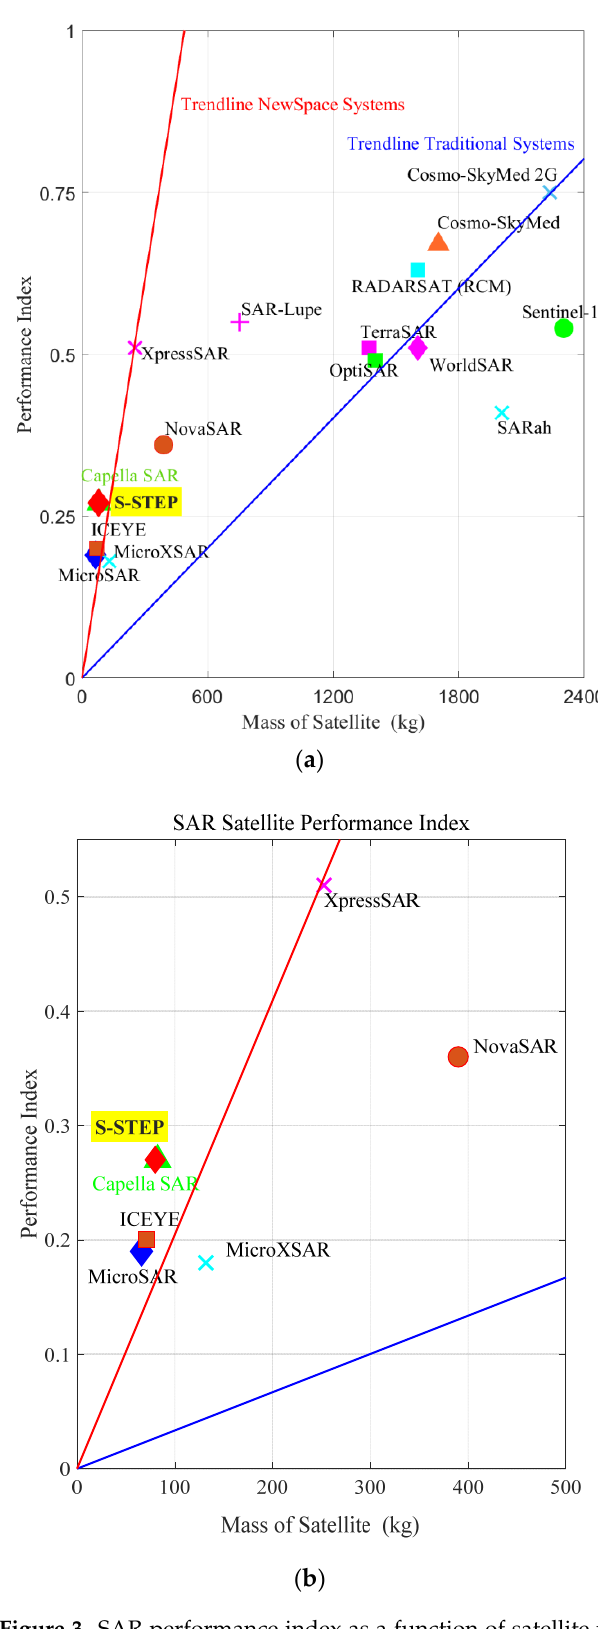
Figure 3. SAR performance index as a function of satellite mass, Adapted from [25] [( a ): Overall View, ( b ): Zoomed View]